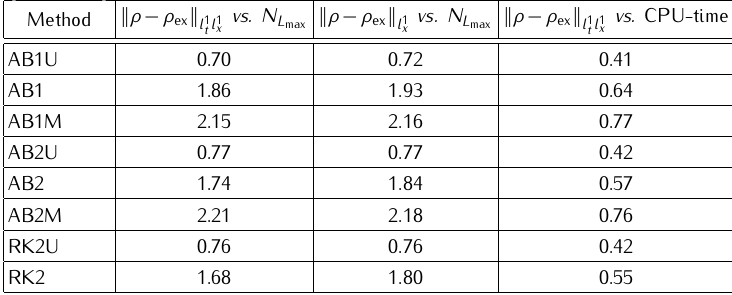
Table 1. Numerical order on the density error using the l 1 the l 1 t l 1 x -norm on the density error with respect to the CPU-time (in the log 10